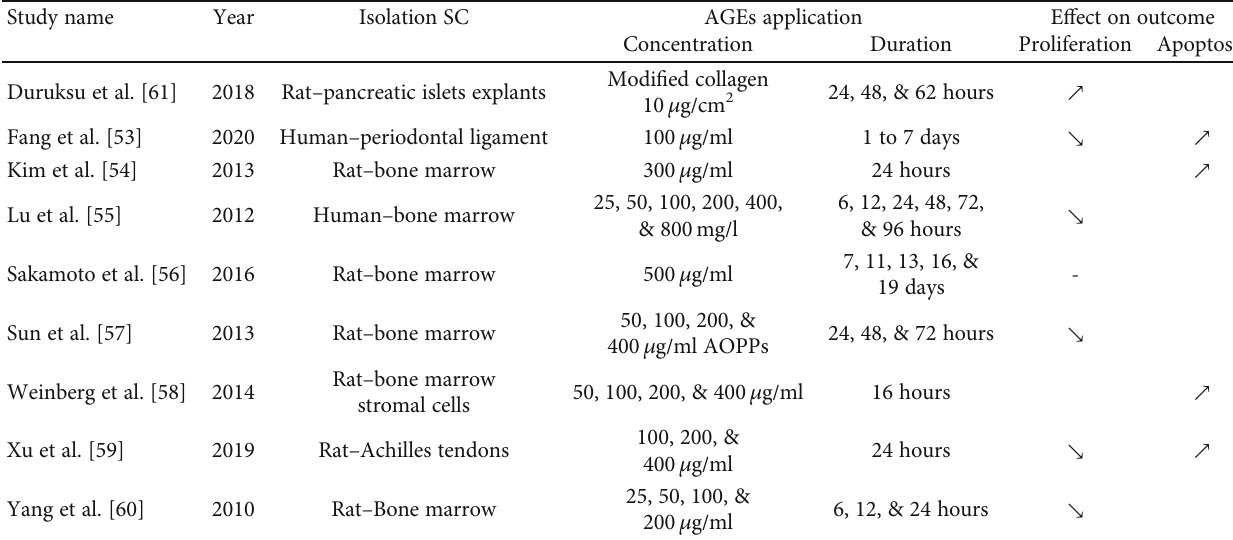
Table 3: Summary of included studies using MSCs. Summary of the isolation procedure and sampling, AGEs concentration, application duration and e ff ect on outcome measurement proliferation and apoptosis.